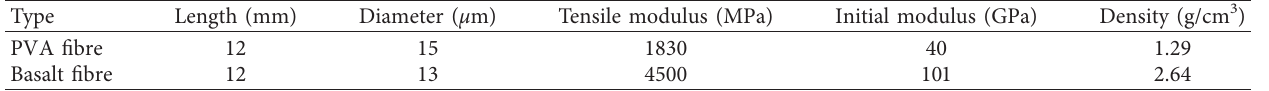
Table 2: Technical indexes of PVA and basalt fibre.